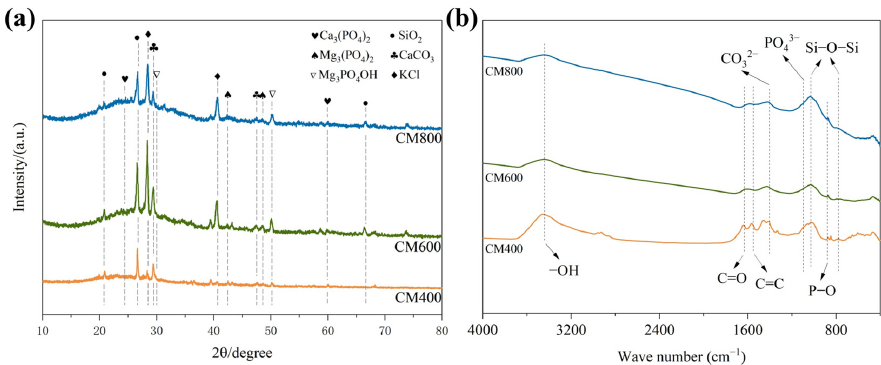
Figure 2. XRD and FTIR spectra of three kinds of CMBC. ( a ) XRD spectra and ( b ) FTIR spectra.